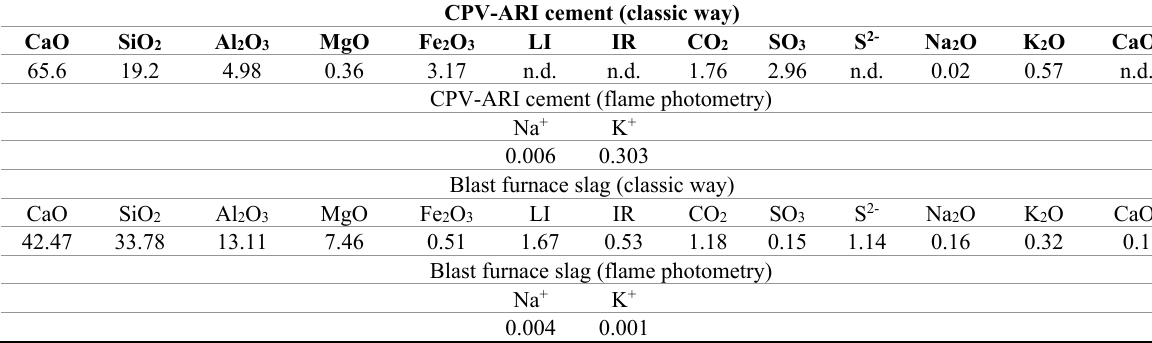
Table 2. Chemical characterization of Portland Cement V - High Initial Resistance (CPV-ARI) and blast furnace slag used by Oliveira [17] (% by